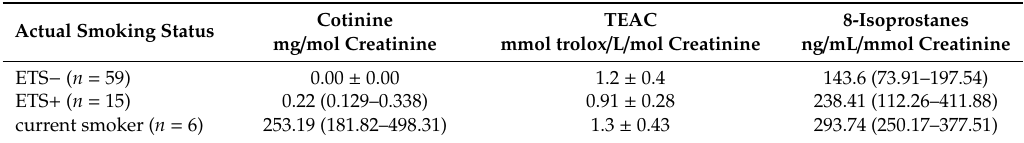
Table 4. Cotinine levels, Trolox-equivalent antioxidant capacity (TEAC), and levels of 8-isoprostanes.